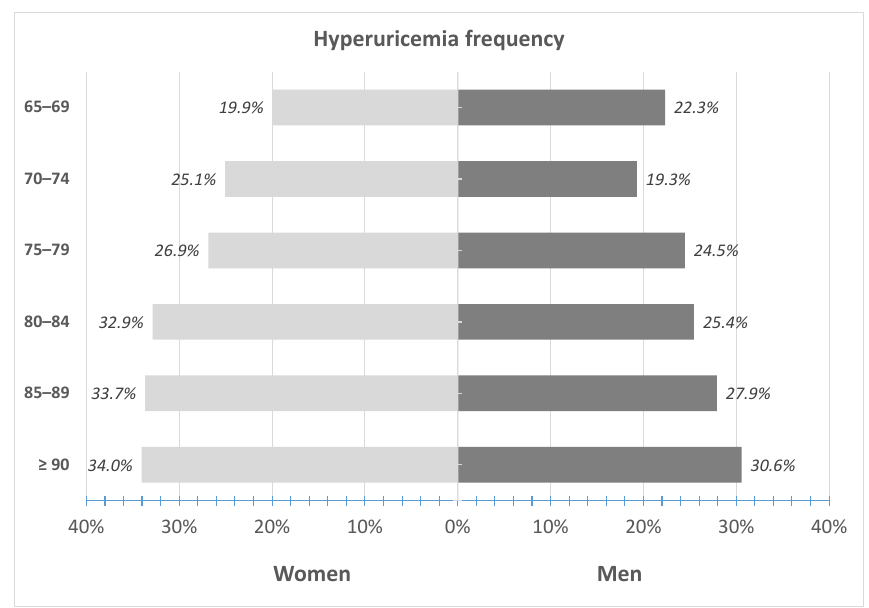
Figure 3. Frequency of hyperuricemia (defined by SUA ≥ 6 mg/dL in women and ≥ 6.8 mg/dL in men) in 5-year interval subgroups.